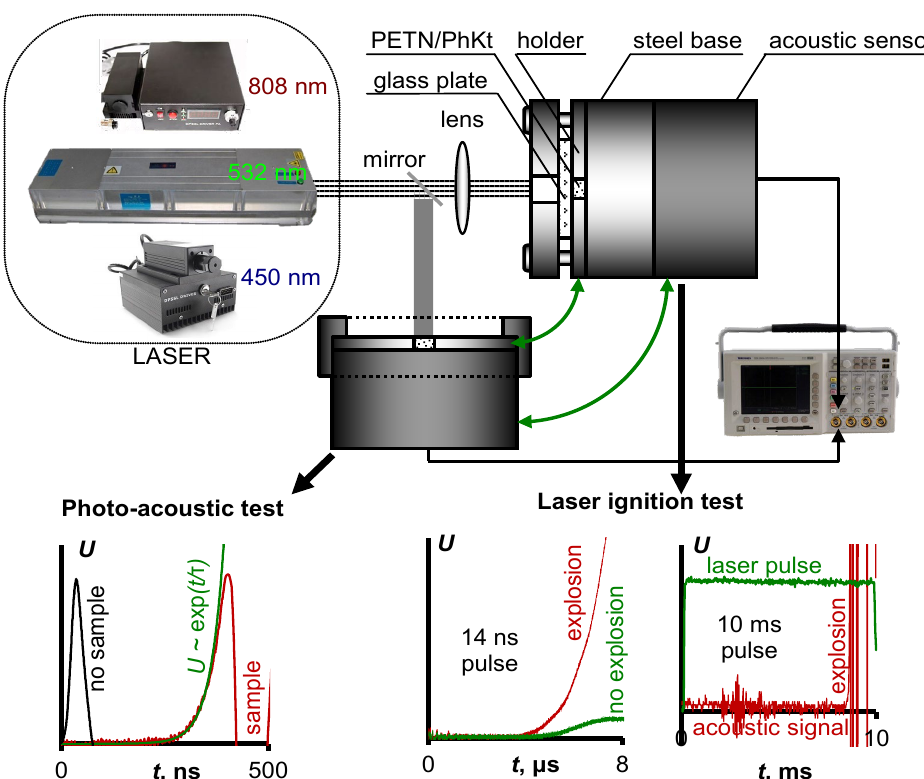
Figure 1. The schematic diagram of photoaucoustic measurements and laser initiation tests.